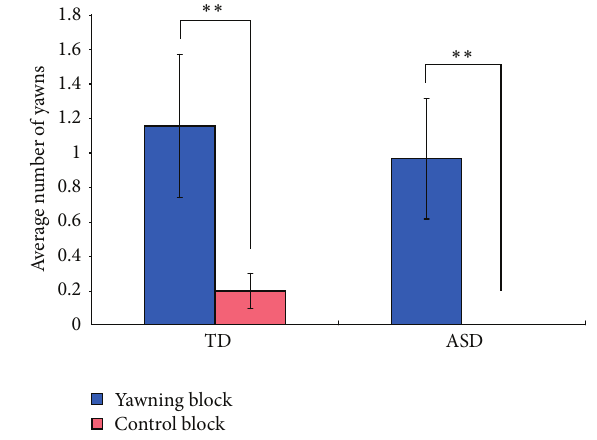
Figure 3: Average frequency of yawns of participants in yawn or control block in Experiment 1. TD: typically developing children; ASD: children with autism spectrum disorder; error bars: standard errors; ∗∗ 𝑃 < .01